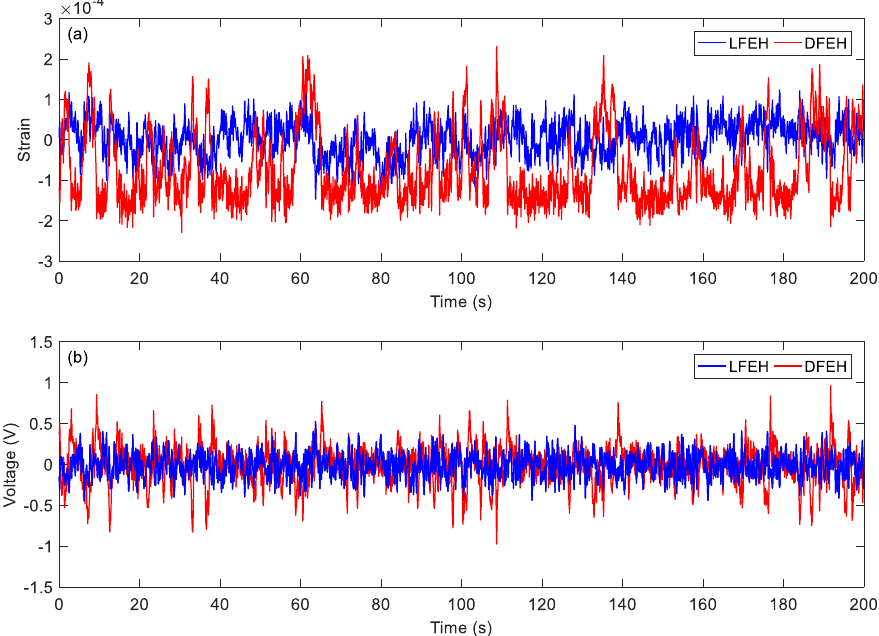
Figure 20. ( a ) Time histories of strain response, ( b ) time histories of voltage response ( v = 7.5 m/s).